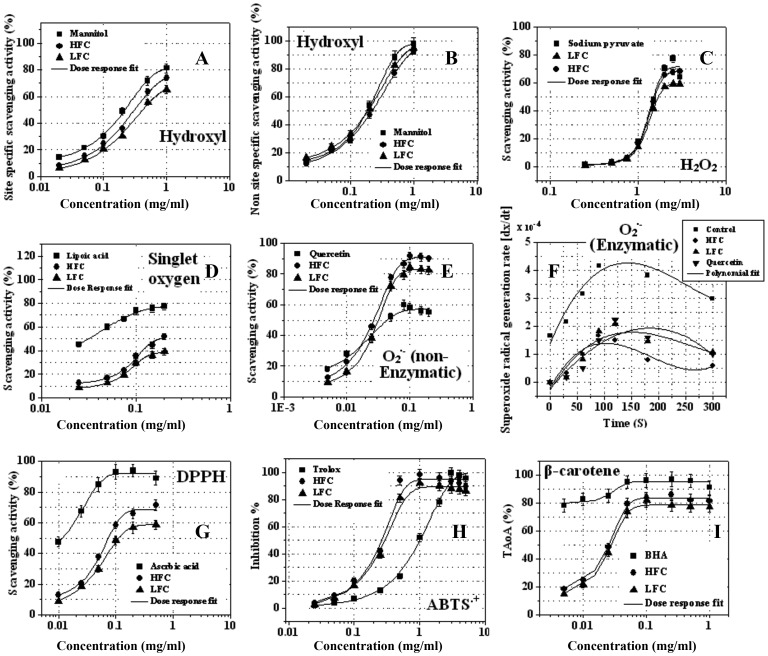
Scavenging performance of purified LFC and HFC polysaccharides against chemically-generated free radicals in vitro.
A) hydroxyl radical (site specific); B) hydroxyl radical (non- specific); C) hydrogen peroxide; D) singlet oxygen; E) superoxide radical anion (non-enzymatic); F) superoxide radical anion (enzymatic); G) DPPH radical, H) total antioxidant capacity (ABTS.+ scavenging); and I) total antioxidant capacity (β-carotene linoleate model). Results are representative of three independent experiments performed in triplicate and are represented as mean ± SD. Inhibition concentration (IC50) values were calculated from pharmacological dose-response curve fit (sigmoidal) the equation: Y =  Bottom + (Top-Bottom)/[1+10∧{(LogIC50-X)* Hill slope}].